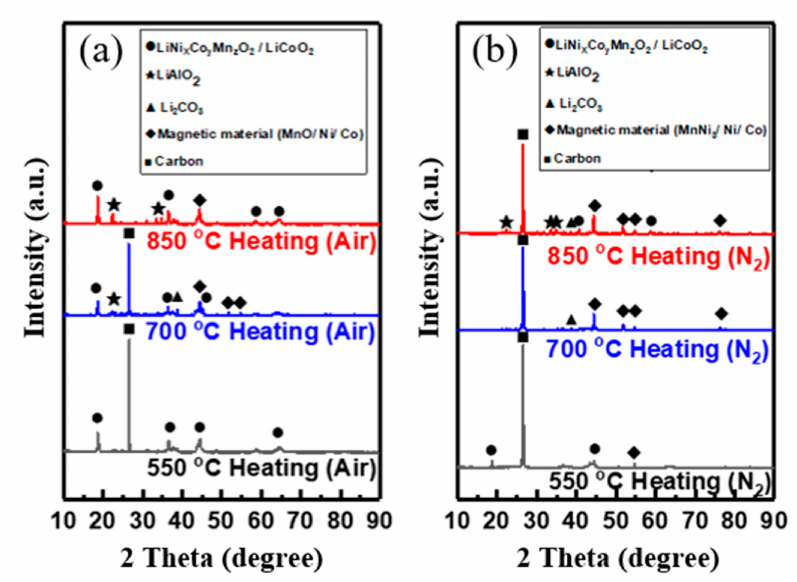
Figure 5. XRD analysis ( a ) in air atmosphere and ( b ) in